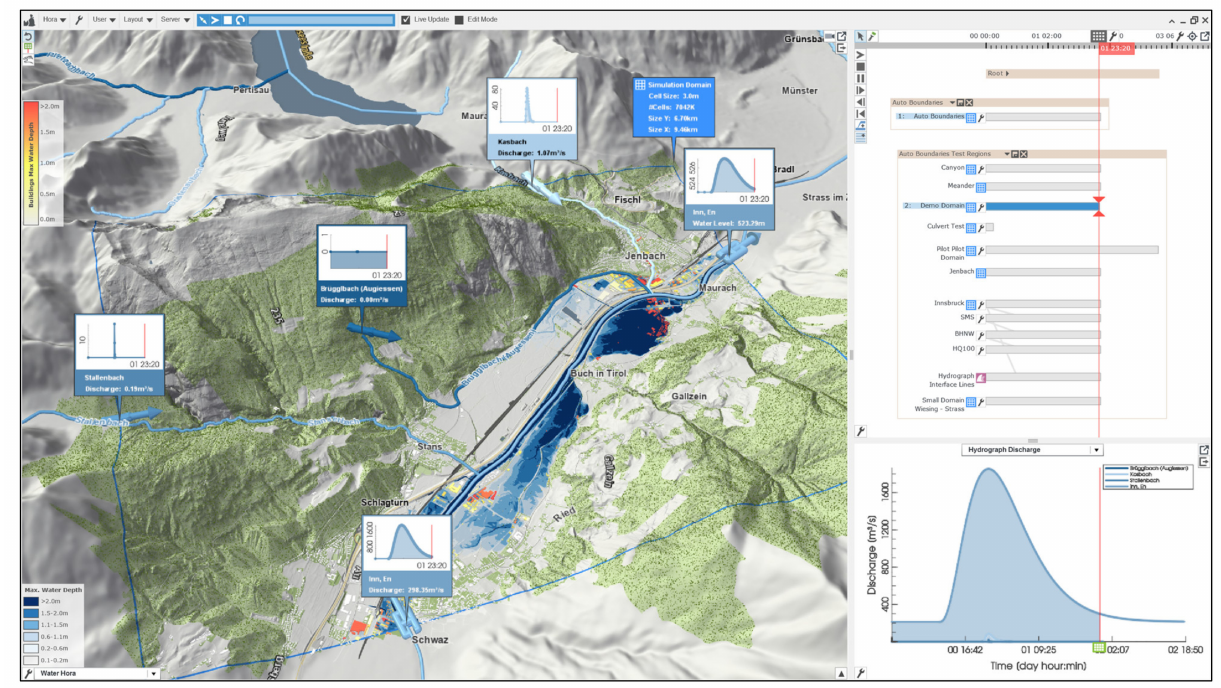
Figure 9. Integrated ensemble-based flood simulation and visualization system with combined 2D (world lines, diverse analytical diagrams) and 3D visualization